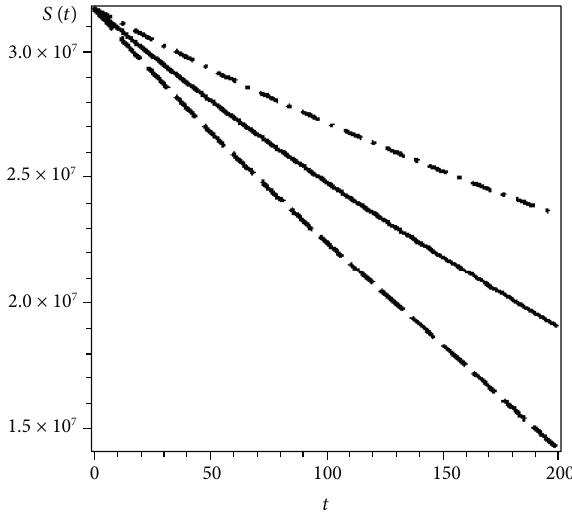
Figure 9: The e ff ect of the number of vaccination on the infected individuals (dashed line, v = 100000 , continuous line v = 75000 , dashed-dotted line, v = 50000